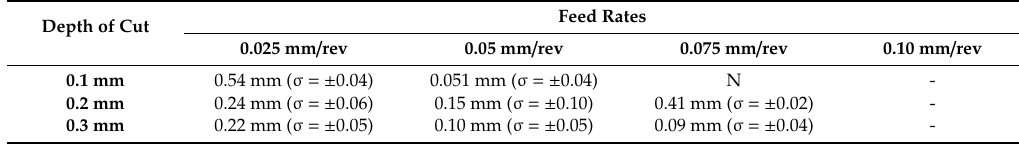
Table 7. Burr heights for TiN-coated tool